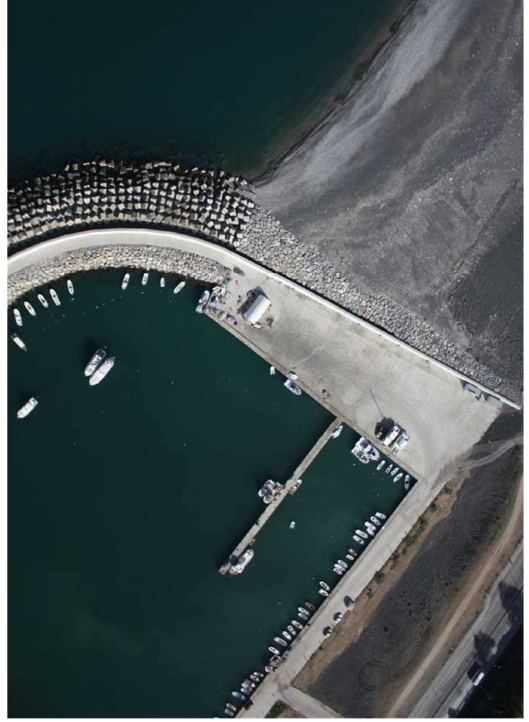
Figure 7 Sample for Hydrographic Details